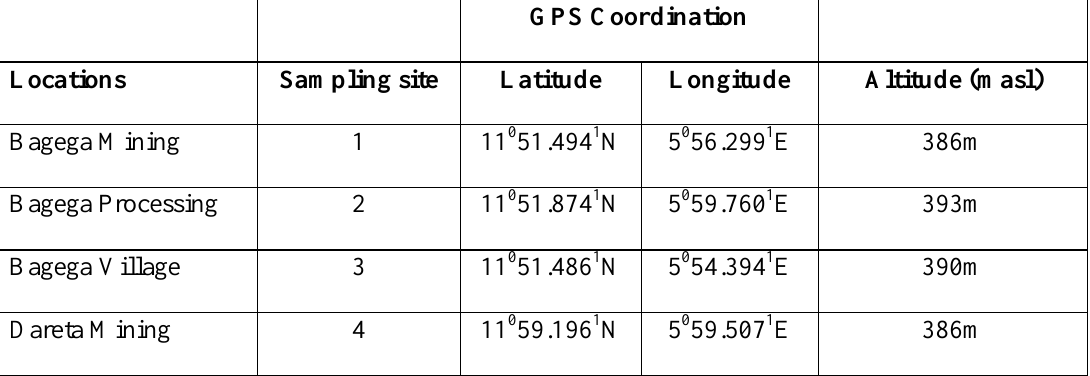
Table 1. Geographic coordinates and altitudes of the sampling points